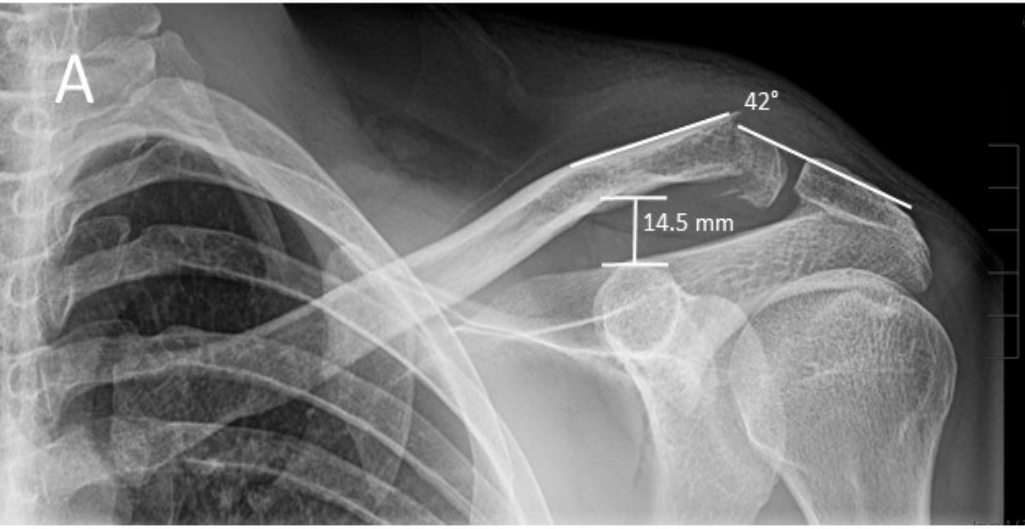
Figure 4. Evaluation method of the fracture angles and CCD in a. p .-X-rays. ( A ) 38-year-old male with Craig IIc fracture. The CCD was 14.5 mm, and the fracture angle was 42°. ( B ) 30-year-old male with Neer I fracture. The CCD was 7.4 mm, and the fracture angle was 26.8°. Operative treatment strategy of unstable fracture types is shown in Scheme 1. The choice of surgical procedure was made according to the current recommendations in the literature. For fracture types located in or distal to the coracoclavicular insertion area ( n = 20 (50%), Craig IIc and Neer IIb, Jaeger/Breitner IIa), plate osteosynthesis with coraco- clavicular augmentation (Dog Bone TM , Arthrex, Naples, FL, USA) was performed in most cases. n = 1 (2.5%) case was treated with plate osteosynthesis without coraco-clavicular augmentation, n = 1 (2.5%) case with a hook plate. Neer V fractures ( n = 4, 6.8%) were treated half with plate osteosynthesis with coraco-clavicular augmentation and half with plate osteosynthesis with open fiber cerclage. The majority of Neer IIa fractures ( n = 10, 71.4%) were treated with plate osteosynthesis. n = 3 (21.4%) of these fractures were treated with plate osteosynthesis with coraco-clavicular augmentation and n = 1 (7.1%) with a titanium elastic nail (TEN).